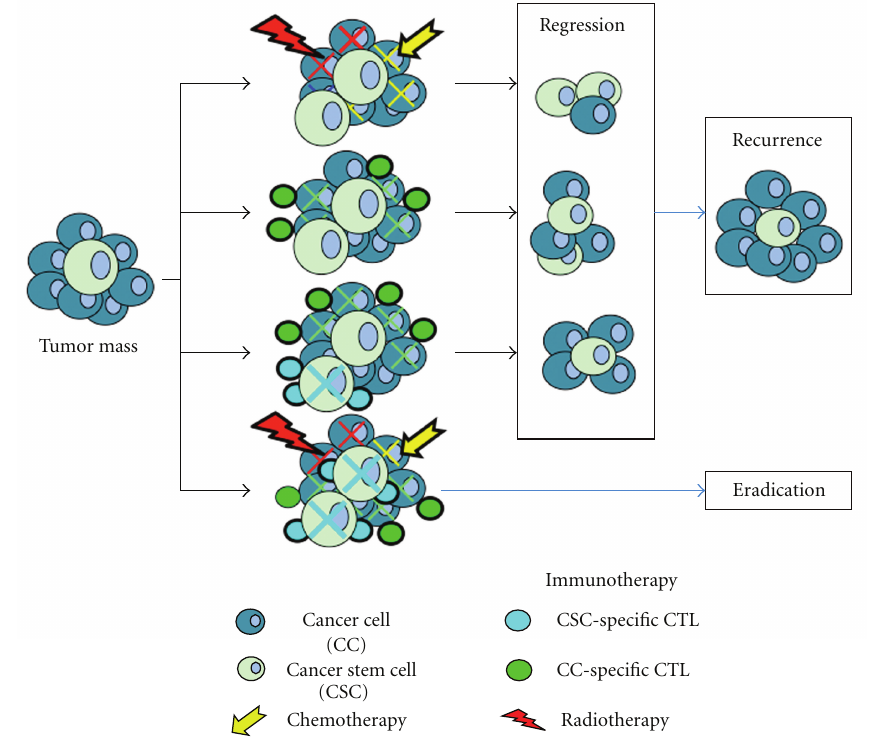
Figure 5: Combination therapies of immunotherapy and standard radio- and chemotherapy. Currently applied standard therapies such as radio- and chemotherapy target bulk cancer cells that are less resistant than cancer stem cells. This leads to initial regression of the tumor mass but eventually regrowth from residual CSCs. Combined therapies of standard therapies and immunotherapeutic approach targeting CSCs would cut o ff the rejuvenating supply of CSCs and resulted in tumor